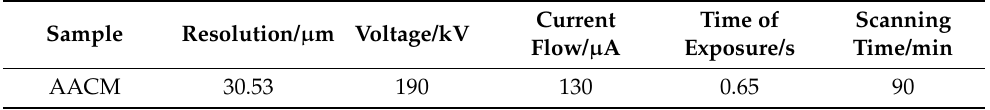
Table 2. Experimental parameters of X-CT